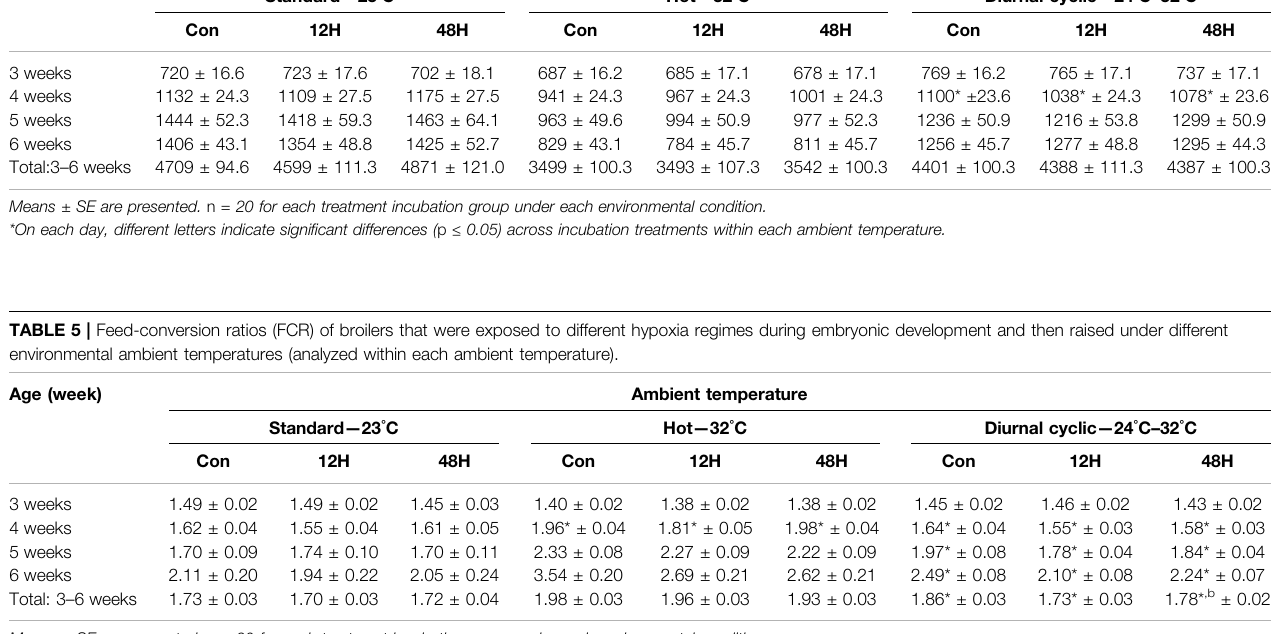
Means ± SE are presented. n = 20 for each treatment incubation group under each environmental condition. *On each day, different letters indicate signi fi cant differences ( p ≤ 0.05) across incubation treatments within each ambient temperature.